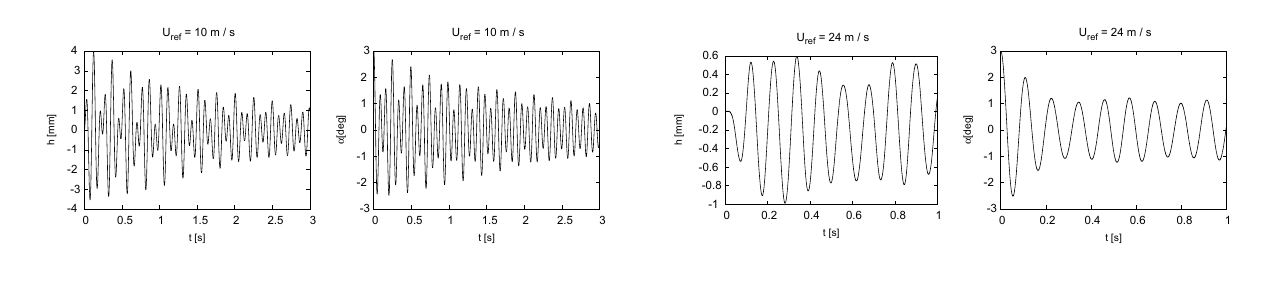
Fig. 10. Aeroelastic response for the seconde considered case in terms of h and α in time domain for far field velocity U ∞ = 10 m / s